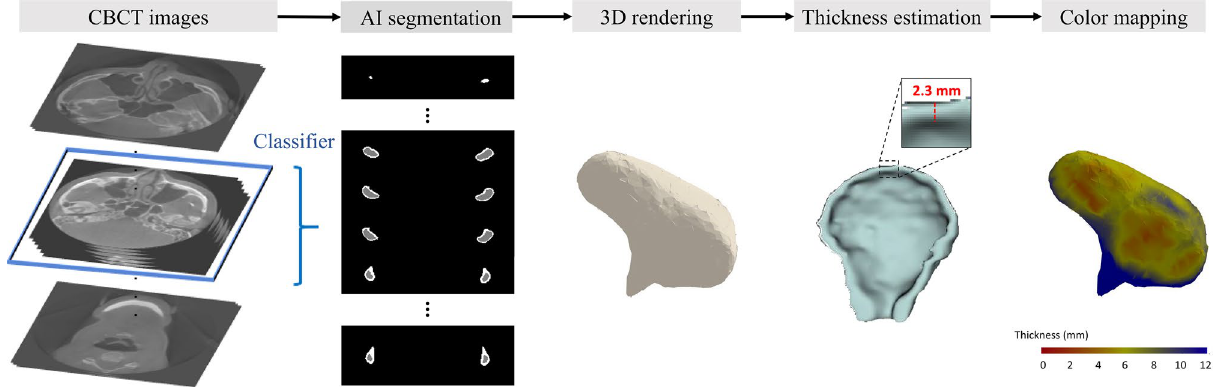
Figure 1. Overall process of the proposed algorithm.